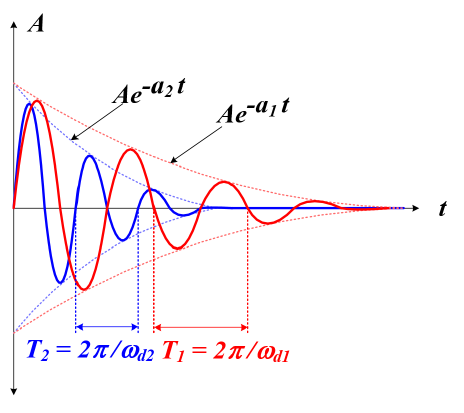
Figure 11. Fourth system response